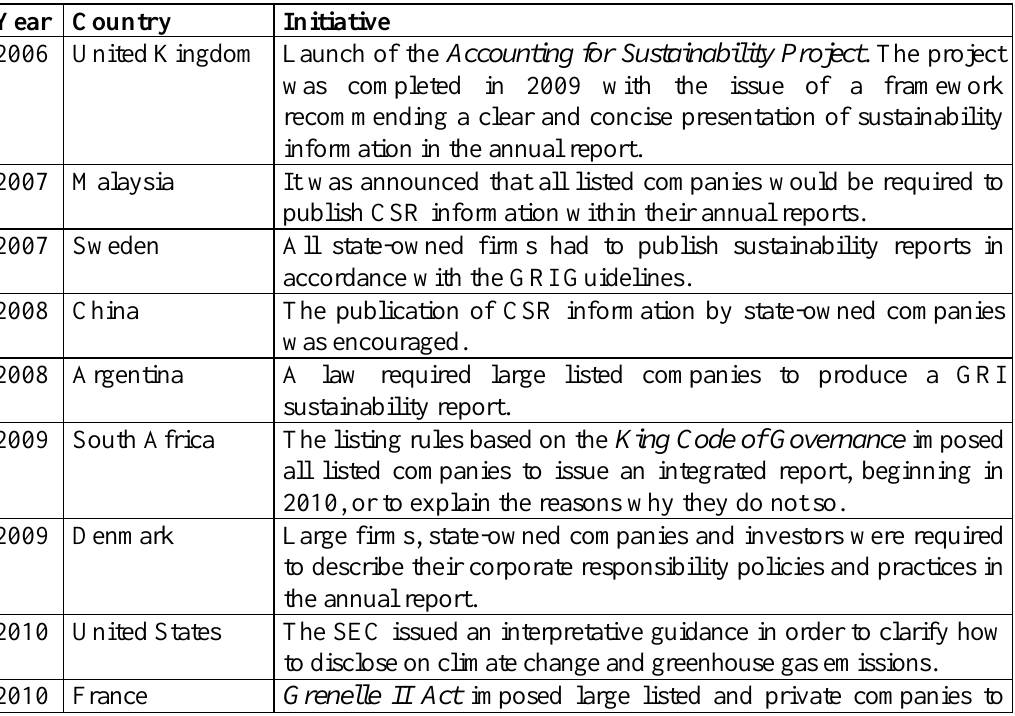
Table 1: Initiatives to promote integrating reporting Year